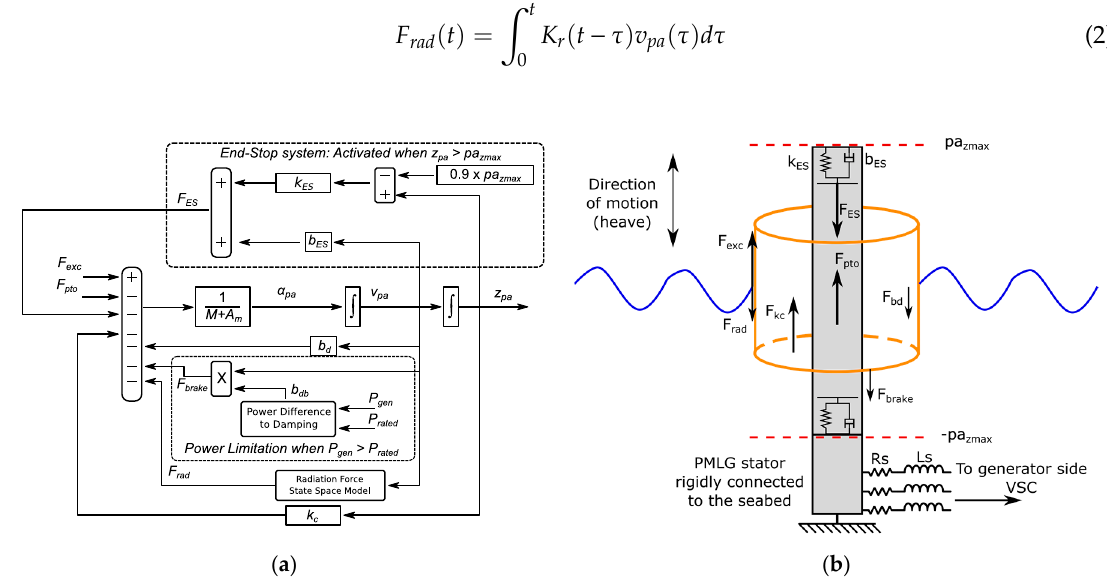
Figure 5. ( a ) Block diagram of the mechanical mass-spring-damper model of the single buoy point absorber described in (1) developed in MATLAB / Simulink; ( b ) Diagram of the WEC and PTO configuration. All forces are acting on the heaving buoy (one degree of freedom).